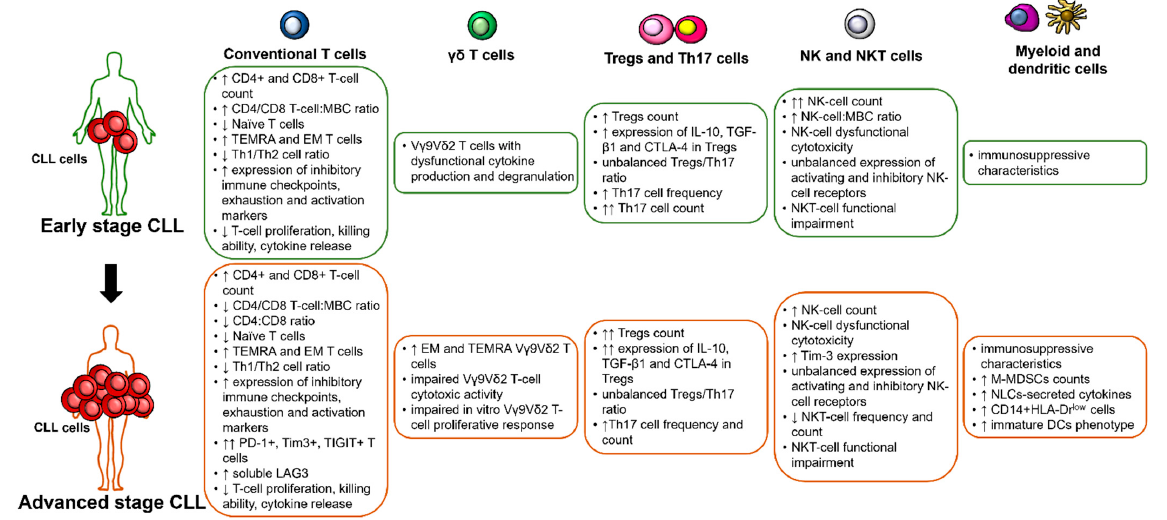
Figure 1. Summary of the main alterations characterizing immune cells of patients with early and advanced stage chronic lymphocytic leukemia. ↓ decreased; ↑ increased; ↑↑ particularly